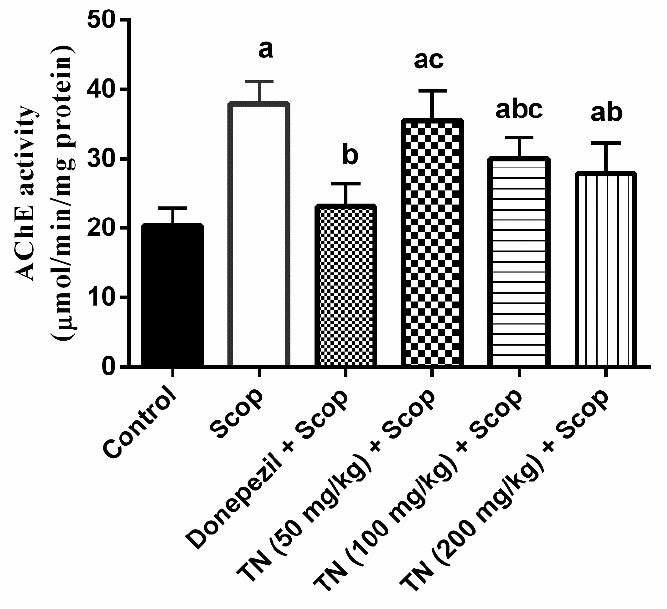
Figure 3. Effect of different doses of tiger nut on Scop-induced alterations in AChE activity. Values are expressed as the mean ± SD ( n = 6). Values are statistically significant at p < 0.05 versus the control group, p < 0.05 versus the Scop-treated group and p < 0.05 versus the donepezil-treated group. 2.4. Effect of Different Doses of TN on Scop-Induced Oxidative Stress Scop produced a state of oxidative stress, revealed by the dramatic elevation in the hip- pocampal MDA level (by ≈ 2.5-fold) along with a significant decline in hippocampal GSH content (by 37.03%) and SOD and CAT activity (by 66.65% and 62.61%, respectively) com- pared with the control animals. However, donepezil and TN 200 mg treatment ameliorated the Scop-induced increase in MDA levels (F (5, 30) = 16.71, p < 0.0001) by approximately 39.04% and 32.79% respectively. Interestingly, compared with the Scop group rats, only donepezil increased the GSH content (F (5, 30) = 6.481, p < 0.0003) by approximately 1.4- fold, while donepezil and TN 100 or 200 mg elevated the SOD activity (F (5, 30) = 28.82, p < 0.0001) by approximately 2.3-fold, 2.2-fold and 2.5-fold, respectively, as well as the CAT activity (F (5, 30) = 12.61, p < 0.0001) by approximately 2.5-fold, 2.7-fold and 2.7-fold, respectively (Figure